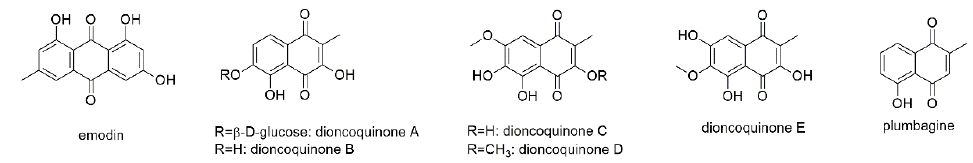
Figure 3. Quinones with reported activity against myeloma cell lines.